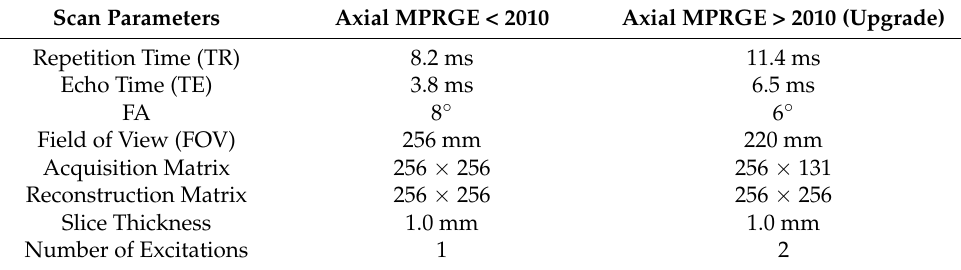
Table 2. Changes in Patient MPRGE Parameters with Scanner Upgrade